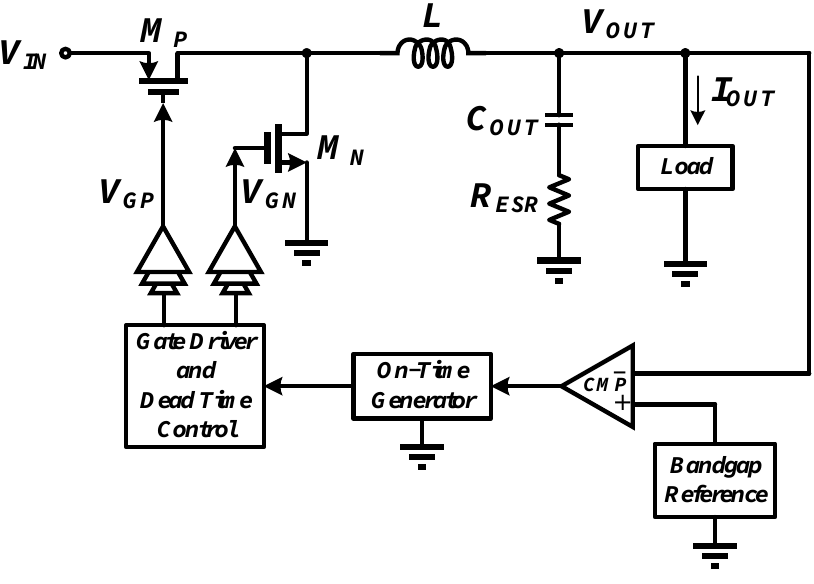
Figure 1. Schematic of the constant on-time DC-DC buck converter.